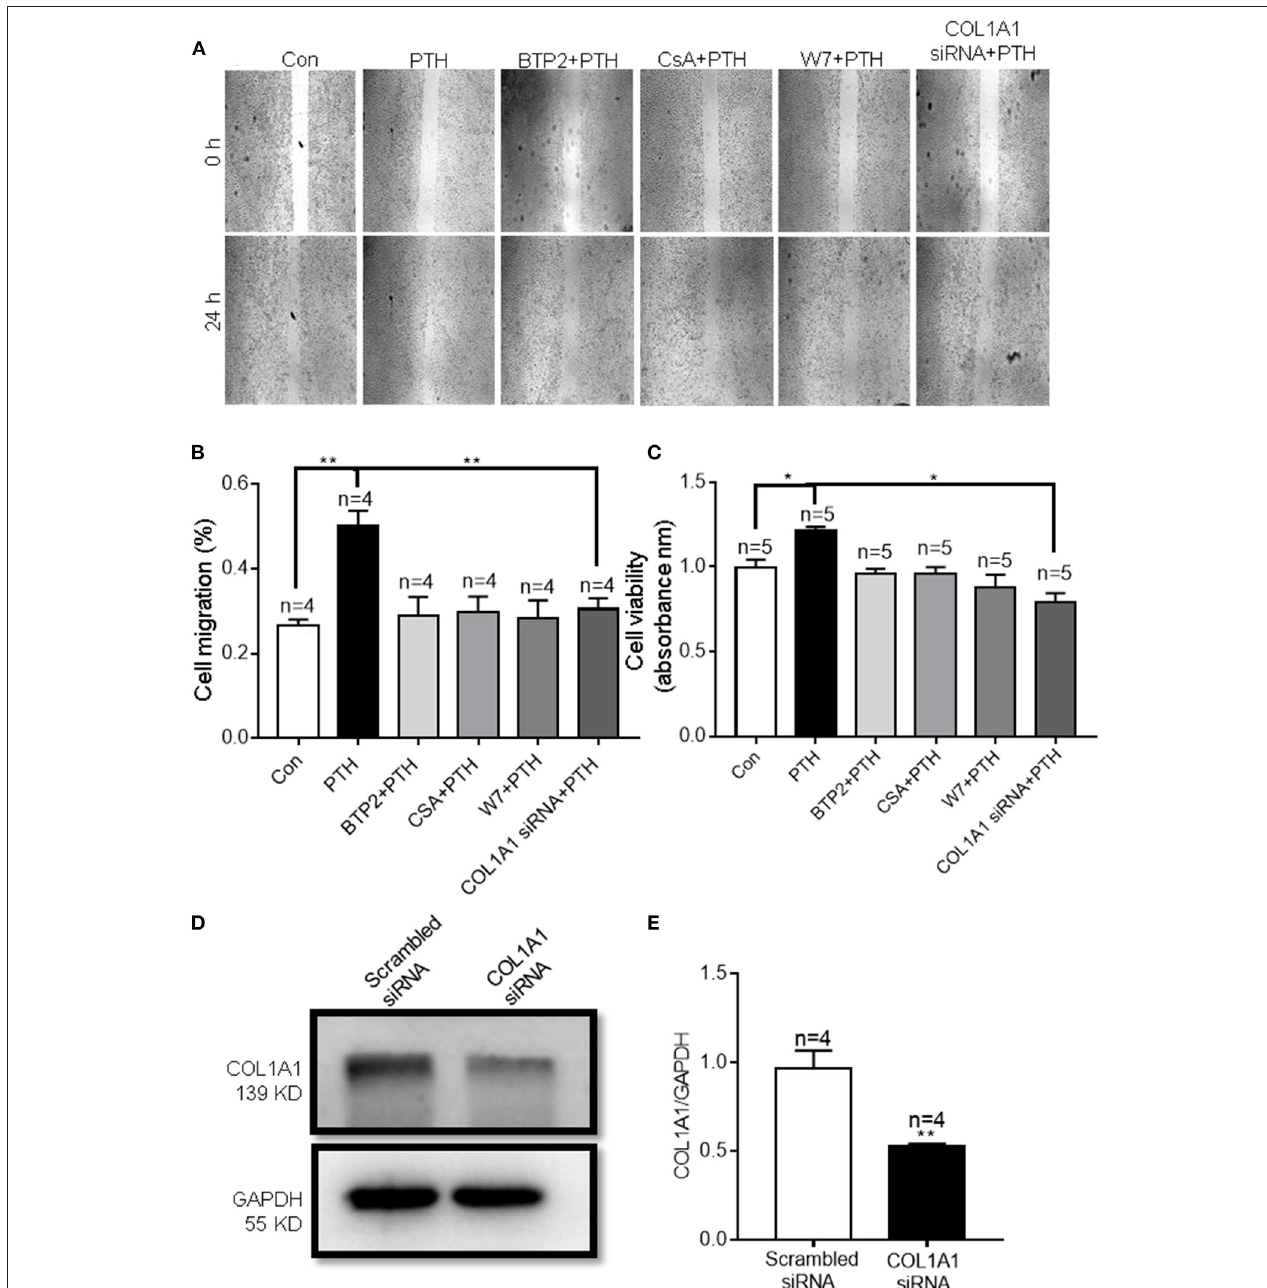
FIGURE 8 | Effect of parathyroid hormone (PTH) on migration of human umbilical vein endothelial cells (HUVECs) (A,B) . (A) Representative images showing the migration of HUVECs treated with vehicle control (Con), 100 pM PTH, PTH + BTP2 (an Orai nonspecific inhibitor), PTH + CsA (calcineurin inhibitor), PTH + W7 (calmodulin antagonist), or PTH + COL1A1 siRNA transfection. (B) Summary data showing the percentage of cells that migrated during 24h. (C) Summary data showing the viability of HUVECs treated with vehicle control, 100 pM PTH, PTH + BTP2, PTH + CsA, PTH + W7, or PTH + COL1A1 siRNA transfection for 24h. Data are shown as the mean ± SEM; n = 4–5. * P < 0.05, ** P < 0.01 vs. Con or PTH analyzed by one-way analysis of variance followed by Dunnett’s multiple comparisons test. (D,E) Representative images and summary data showing the effect of scrambled siRNA or COL1A1 siRNA transfection on COL1A1 expression in HUVECs. GAPDH was used as a loading control. Data are shown as the mean ± SEM; n = 4–5. ** P < 0.01 vs. Scrambled siRNA. components of SOCE may contribute to different responses. study showed that Orai1 was involved in the PTH-induced Orai1 is likely a key mediator in PTH-induced endothelial increase in SOCE activity in HUVECs, whereas Orai2 and dysfunction in Orai3 did not participate. These findings indicate that different